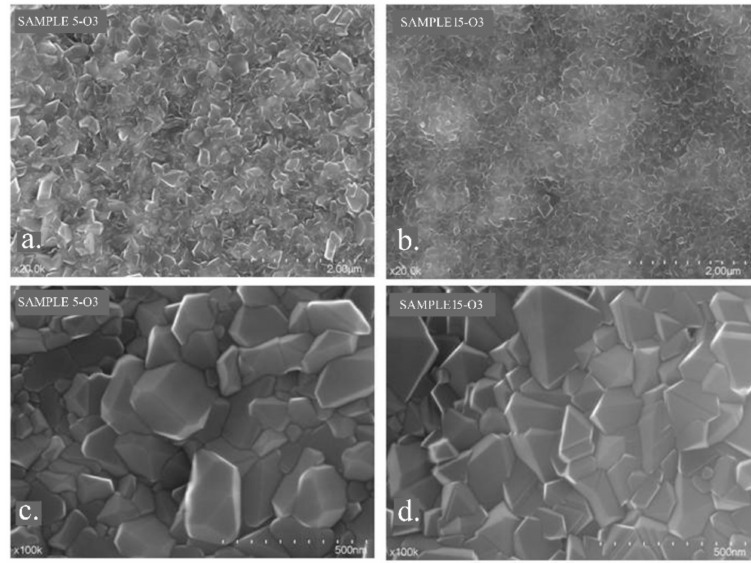
Figure 10. Surface SEM images: ( a , c ) sample 5-O3; ( b , d ) sample